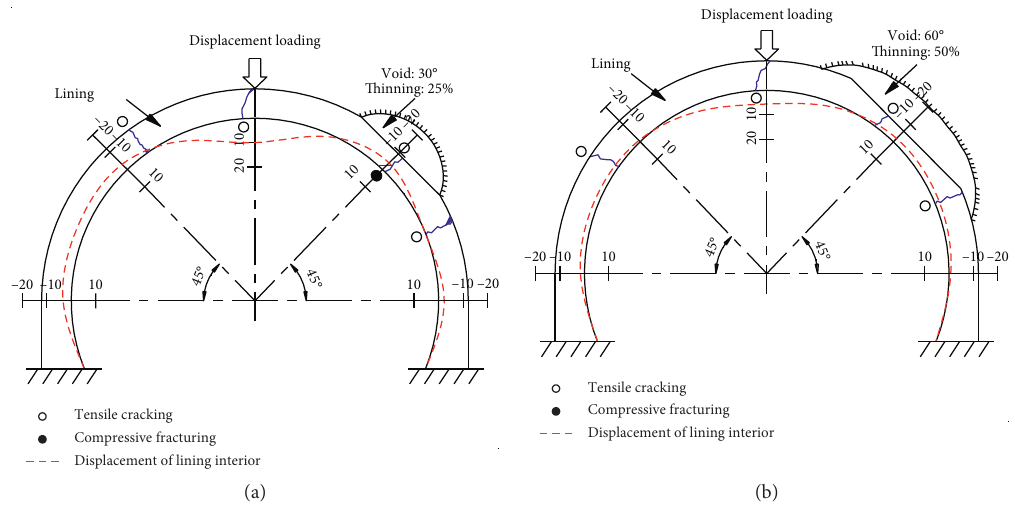
Figure 19: Distributions of lining cracking and deformation at the peak load (defects at spandrel, displacement unit: mm): (a) V30T25 and (b)